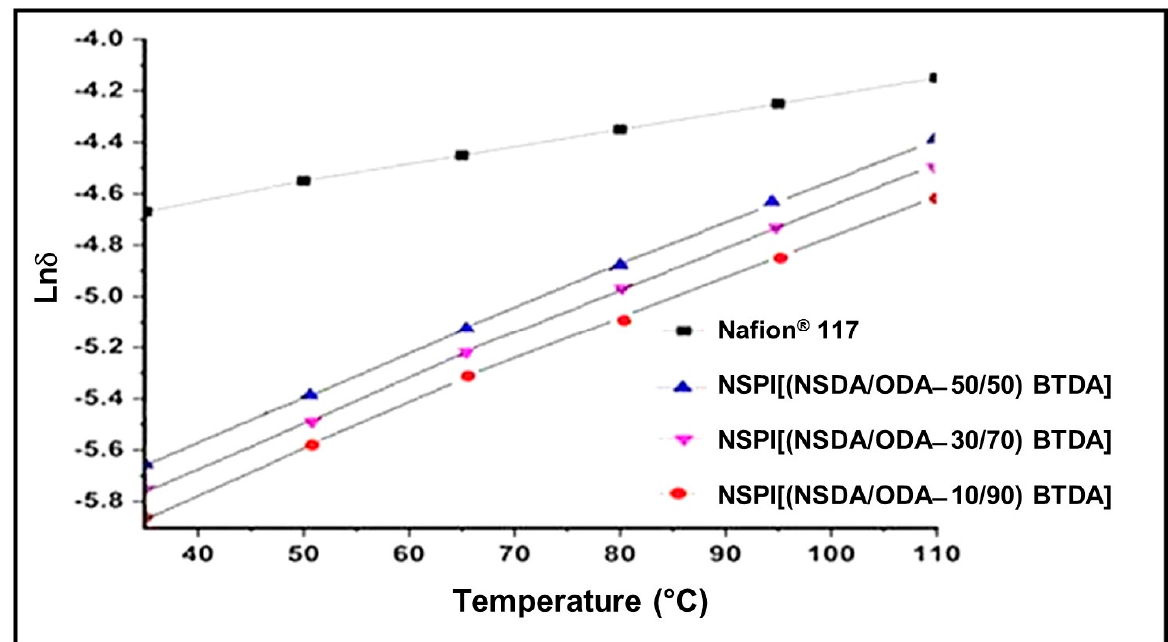
Figure 6. Proton conductivity of NSPIs film vs. Nafion ® 117.